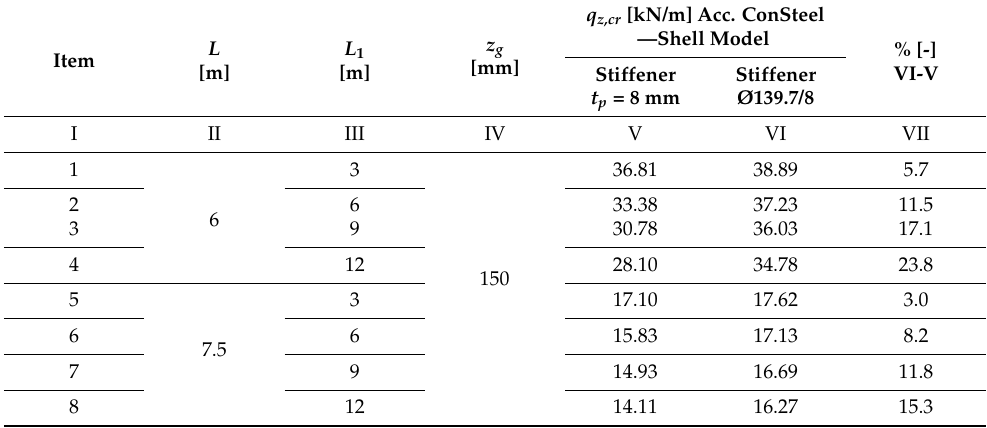
(critical) beam B–E, uniformly loaded ( z g = + h /2), from ConSteel (shell